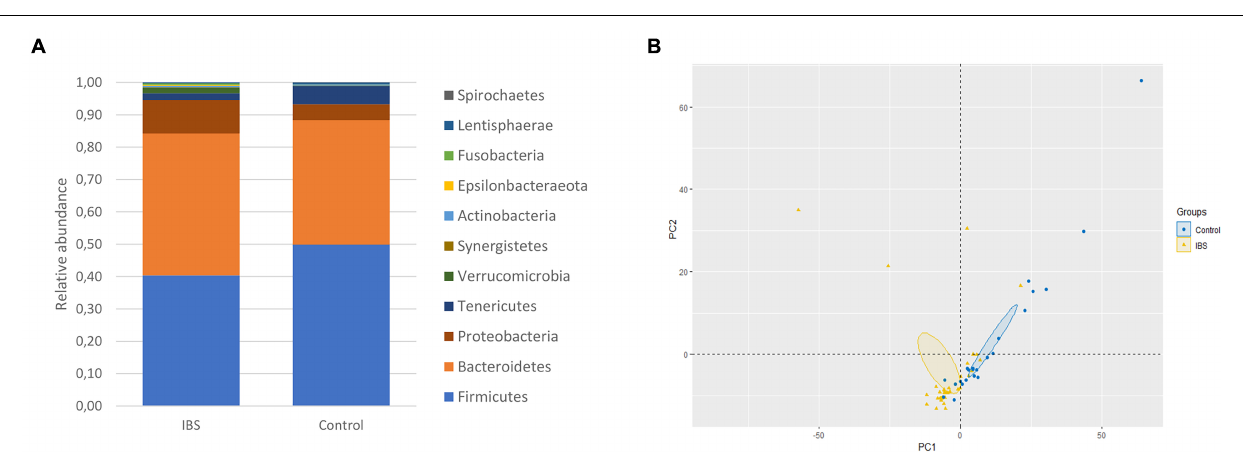
FIGURE 2 | Bacterial alterations in IBS. (A) Comparison of the fecal bacterial microbiota composition between controls and IBS-C subjects at the phylum level. (B) PCoA of the unweighted UniFrac distance of control (blue plots) and IBS (yellow plots)